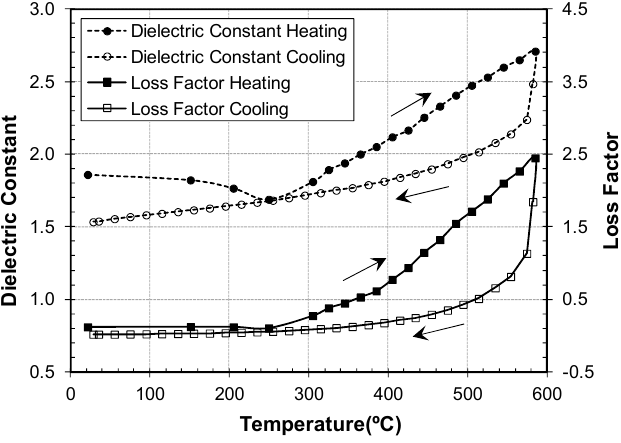
Figure 4. Dielectric properties of zeolite CBV100 ® at microwave frequencies during the heating and cooling cycle.